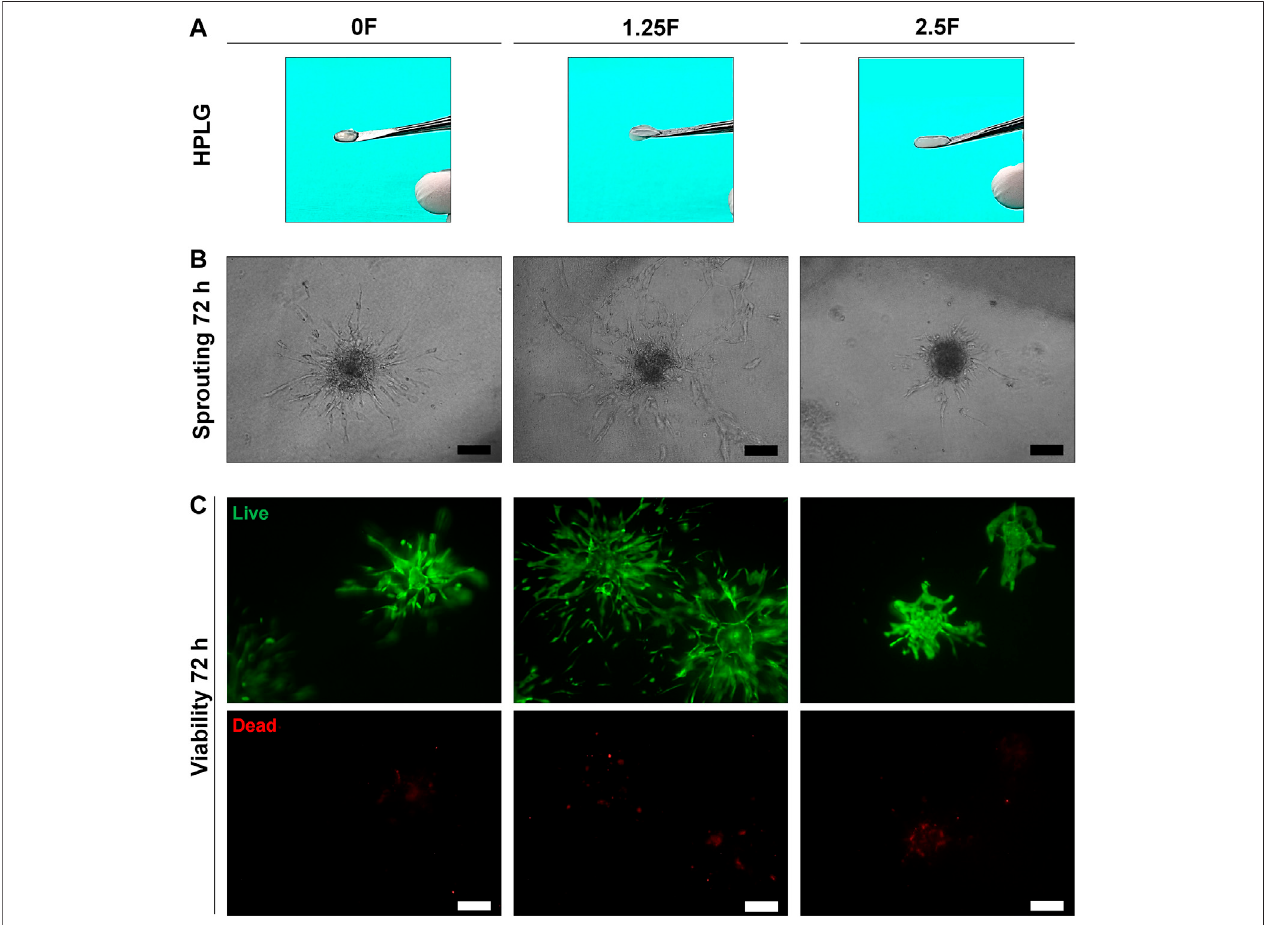
FIGURE4| OptimizationofHPLG. (A) Representativephotographsofunmodi fi ed(0F)andmodi fi edHPLGsupplementedwith1.25(1.25F)or2.5 mg/ml fi brinogen (2.5F). (B) RepresentativephasecontrastimagesofHUVECsproutingafter72 hinthecorrespondingHPLG(scalebars100 μ m). (C) CellviabilityviaLIVE/DEADassayin HUVEC spheroids after 72 h in the corresponding HPLG (scale bars 100 μ m).